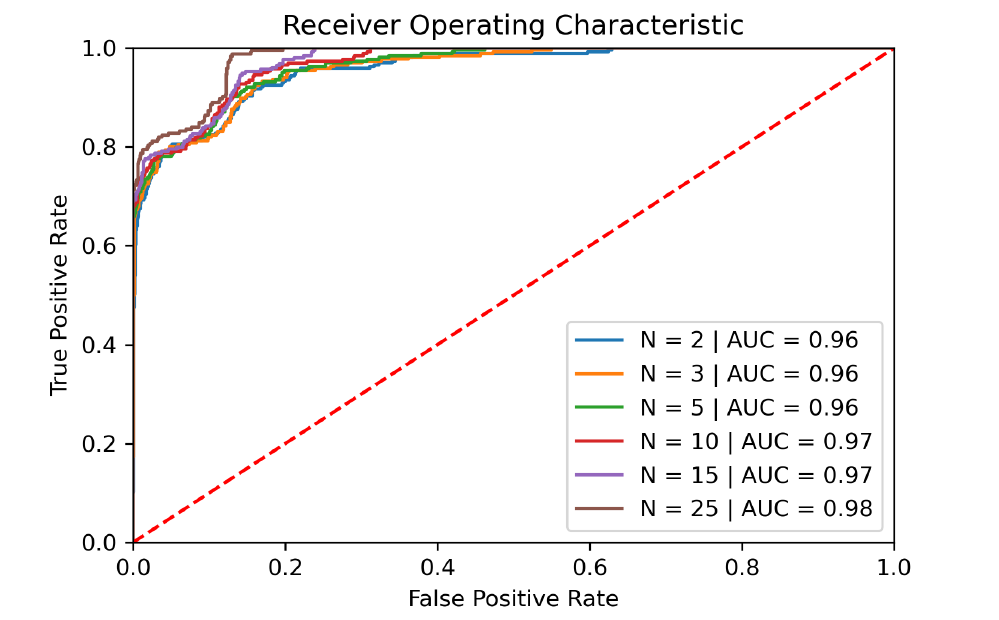
Figure 7. ROC Multiple Gestures for Position, Accelerometer and Timestamp Data with All Gesture Lengths—4 Hidden States and 4